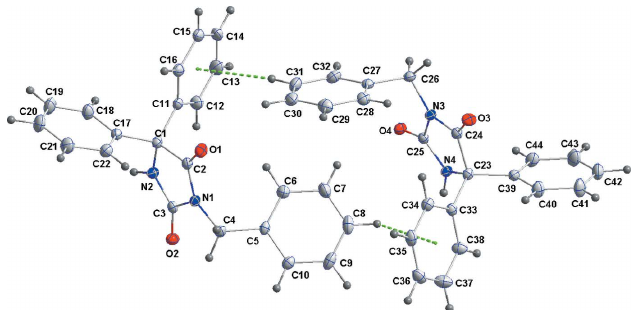
Table 1 Hydrogen-bond geometry (A˚ , (cid:3) ).